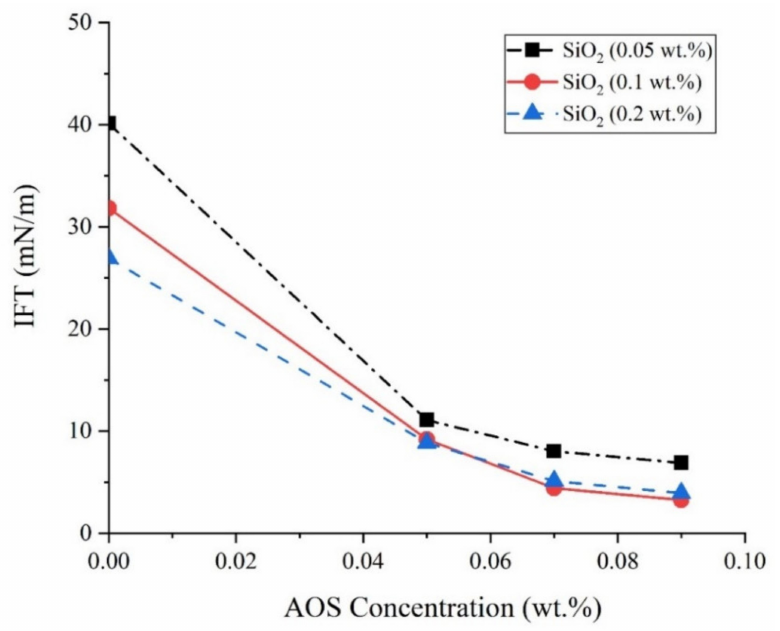
Figure 12. IFT values between the crude oil and the aqueous